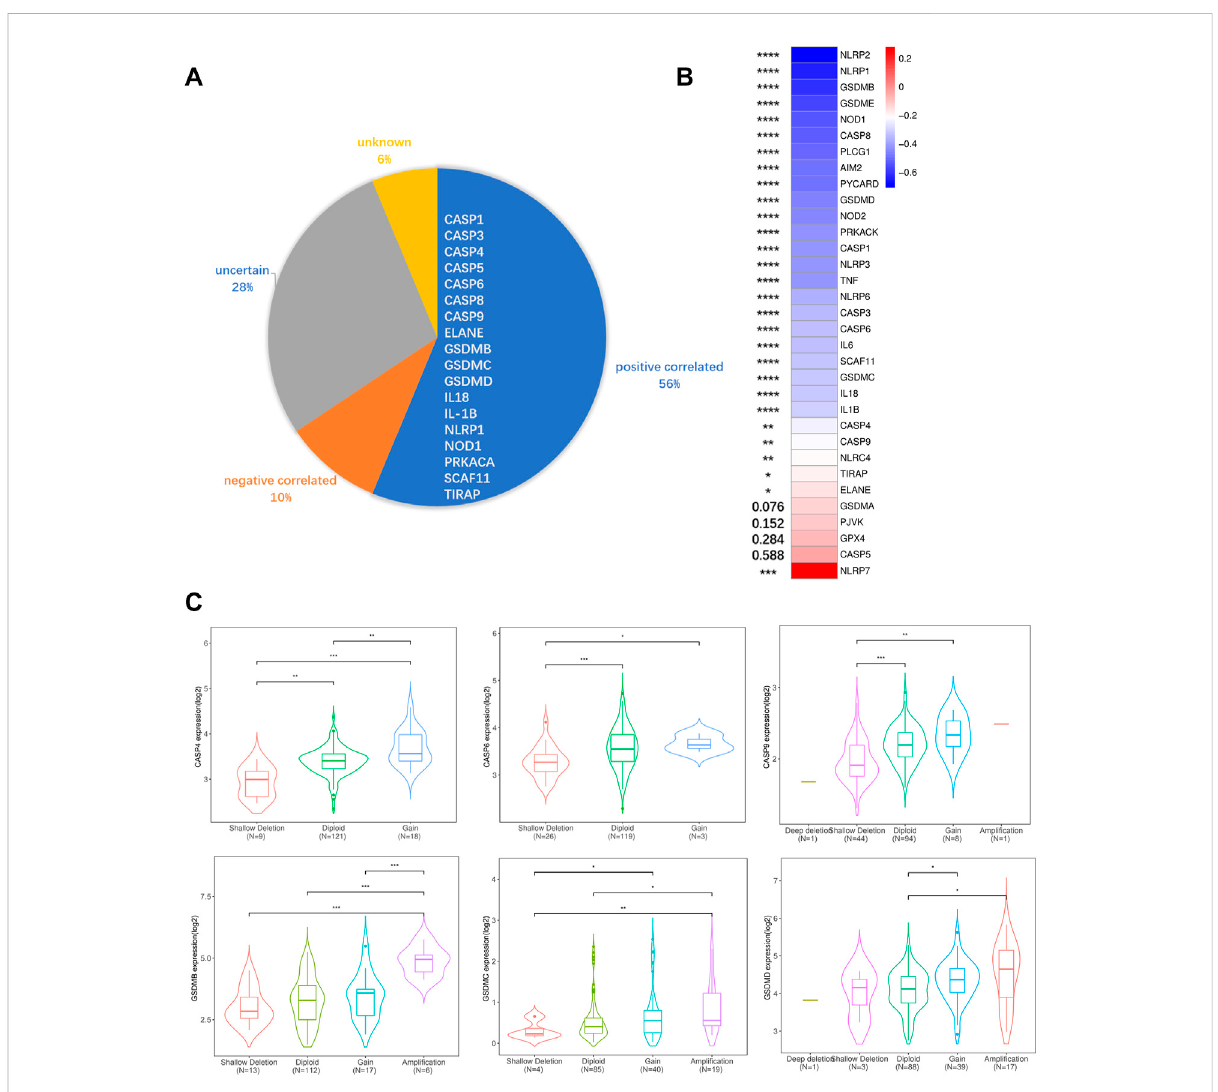
FIGURE 3 DNA methylation, CNV, and gene expression correlation analysis. (A) Correlations between CNV and PRGs expression. Positive correlation was de fi ned as certain PRGs expression increased while copy number augmented. Negative correlation was de fi ned as certain PRGs expression decreased while copy number augmented. Uncertain was de fi ned as both expression increasement and decrement can be observed while copy number augmented. Unknown was de fi ned as no signi fi cant differences between different CNV groups. (B) Pearson correlative value between methylation(HM450)versusmRNAexpressionz-scoresrelativetoallsamplesofeachPRGs. (C) ViolinplotsofexamplepositivecorrelatedPRGs.The rest PRGs are presented in Supplementary Figure S2. Signi fi cance was determined using the Mann-Whitney or unpaired t-test. Data shown